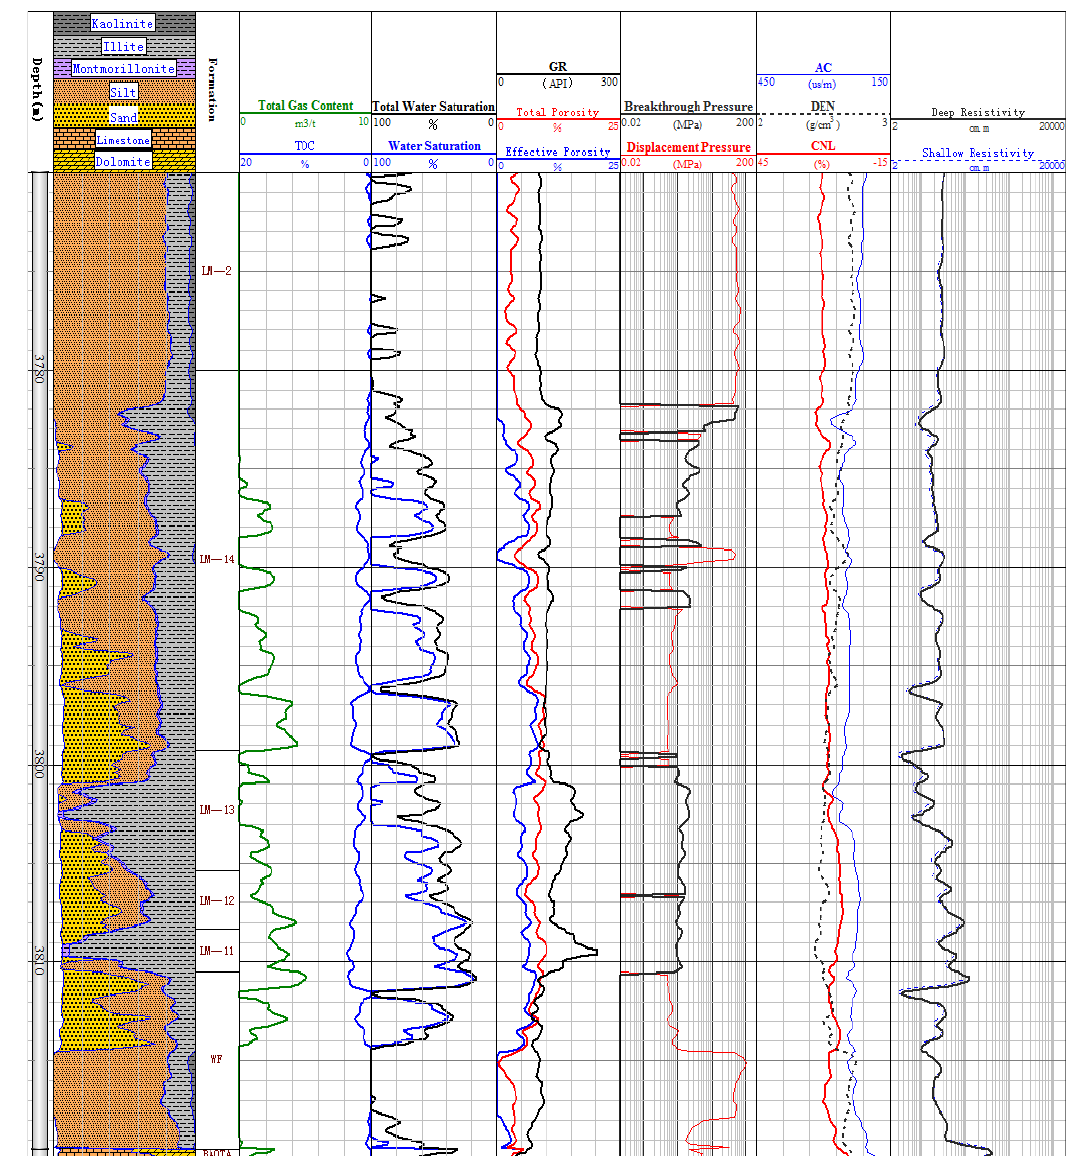
Figure 14. Calculated breakthrough pressure of shale caprocks.